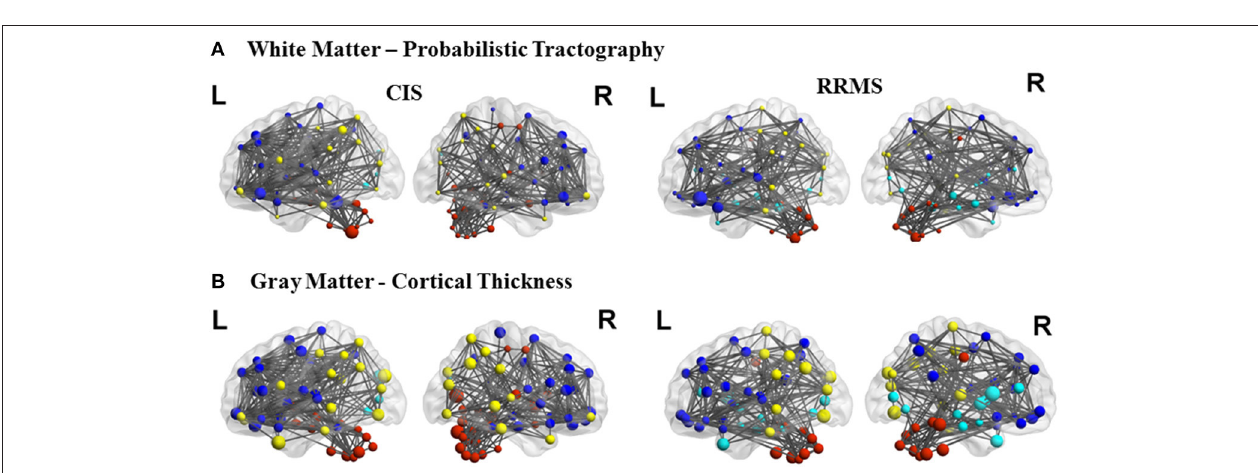
FIGURE 3 | Topological representation of the parameter clustering coefficient (size of the nodes), structural connections (links), and modules (color of the nodes) for CIS and RRMS. Left (L) and right (R) hemispheres are shown. The first row shows the white matter connectivity derived from DTI and probabilistic tractography and the second row from the cortical thickness correlation